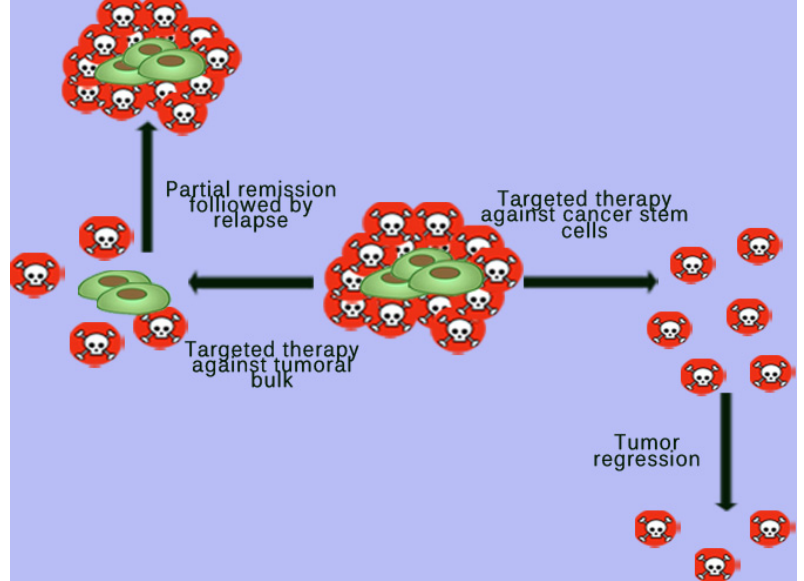
Figure 2. Targeted therapy against cancer stem cells. Therapeutics aimed at the general population of cancer cells has a limited impact on cancer stem cells (CSCs). In time, their regenerative and proliferative capabilities are responsible for the relapse. On the contrary, therapy aimed at the CSC population determines a destruction of the population responsible for differentiation and proliferation which in turn produces a much more pronounced and stable tumoral regression. The CSCs are displayed as the green, larger cells while the non-stem cells are depicted as the smaller, red with the skull and bones in the